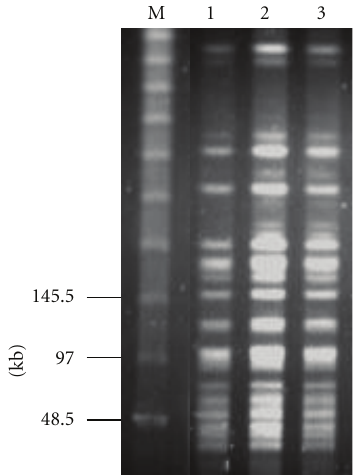
Figure 1: PFGE patterns of Sma I-restricted genomic DNA of Bacillus cereus isolates yielded from blood or cerebrospinal fluid culture specimens. Lane M: molecular weight marker; lane 1: B. cereus 006; lane 2: B. cereus 007; lane 3: B. cereus 008. Numbers on the left are DNA size markers (kb). Table 1: Antimicrobial susceptibilities in Bacillus cereus isolates.